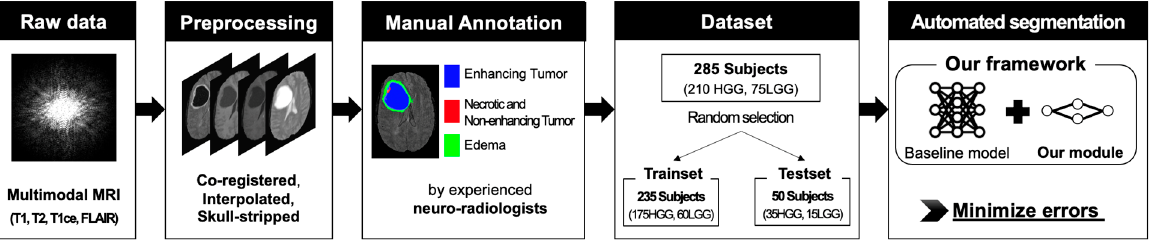
Figure 1. Flow diagram of our study. Brain tumor segmentation on MRI was automatically performed, and three types of lesions (enhancing tumor, necrotic/non ‐ enhancing tumor, and edema) were distinguished. The proposed framework can minimize the error of the baseline model. To evaluate the framework, we used a public dataset, BraTS18. T1 = T1 ‐ weighted; T1ce = T1 contrast ‐ enhanced; T2 = T2 ‐ weighted; FLAIR = Fluid Attenuated Inversion Recovery; HGG = high ‐ grade glioma (glioblastoma); LGG = low ‐ grade glioma.